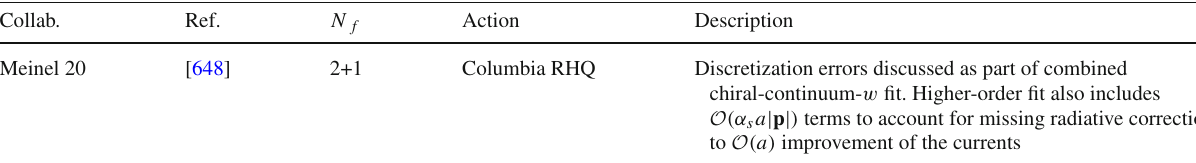
Table 164 Heavy-quark treatment in determinations of form factors for rare decays of beauty hadrons Collab.